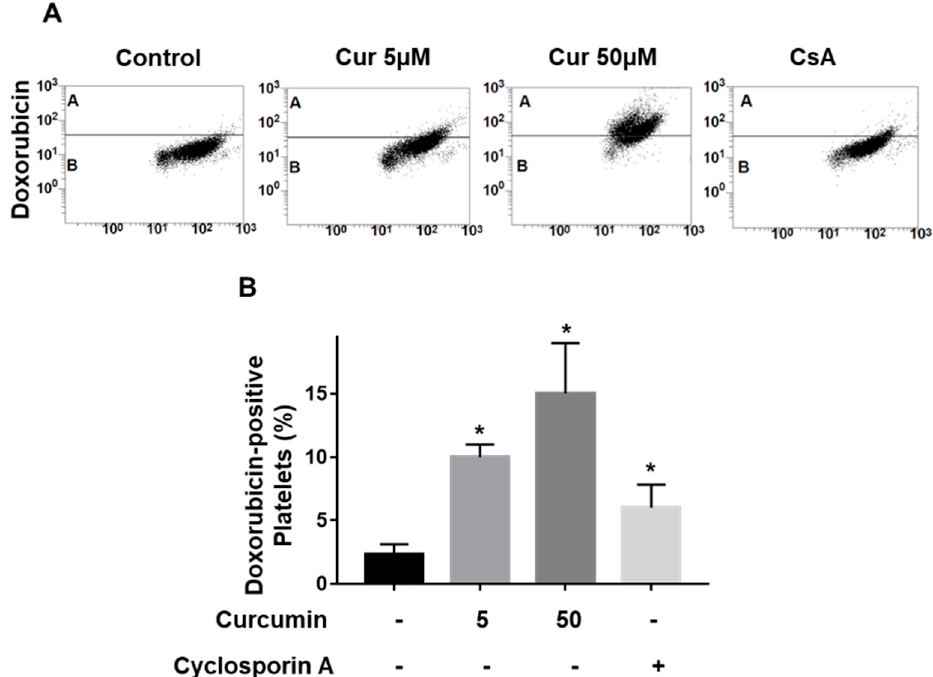
Figure 2. Curcumin increases doxorubicin accumulation in platelets. Washed platelets (1 × 10 8 /mL) were incubated with the indicated concentrations of curcumin alone or in combination with doxorubicin (20 µ M) for 60 min in the absence (control) and analyzed by flow cytometry for doxorubicin fluorescence. P-gp inhibitor cyclosporin A was used as a positive control. ( A ) Representative dot plots, ( B ) quantification of six independent experiments (curcumin autofluorescence was subtracted from 50 µ M curcumin samples). Data are presented as means ± SD (One-way ANOVA, Levene’s test p < 0.05 followed by Tamhane’s T2 test, * p = 0.01 compared to control, n =